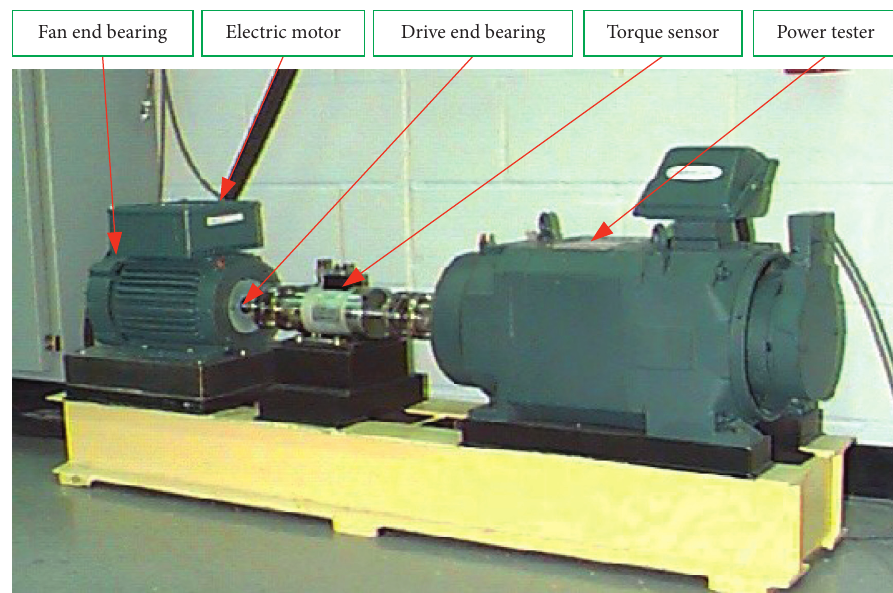
Figure 7: The fault simulation test platform of rolling bearing. Table 1: The brief information of the